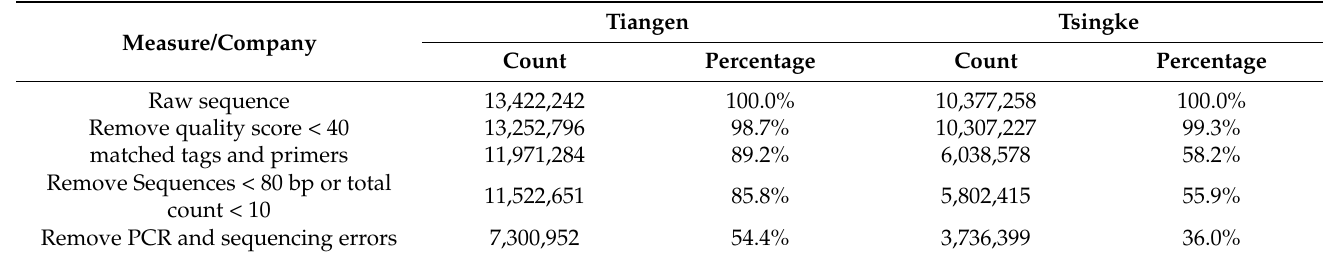
Table 1. Accounting of all sequences produced by next-generation